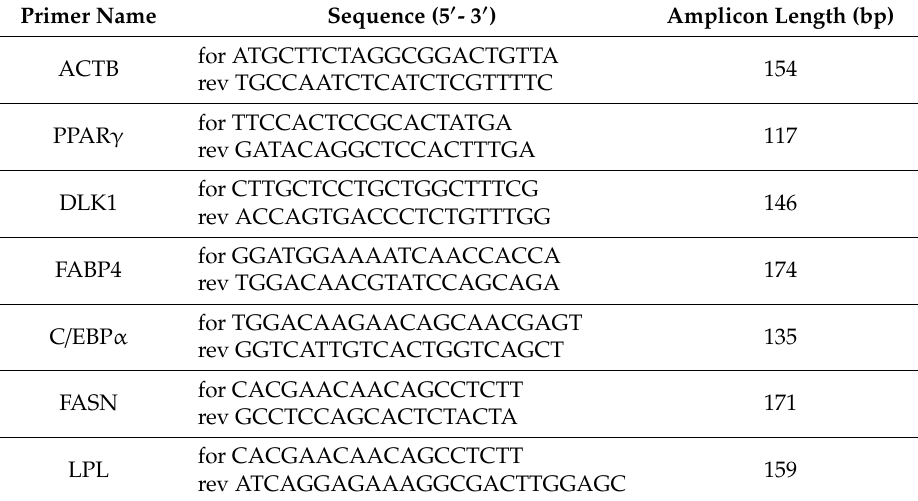
Table 1. Primer sequences used for